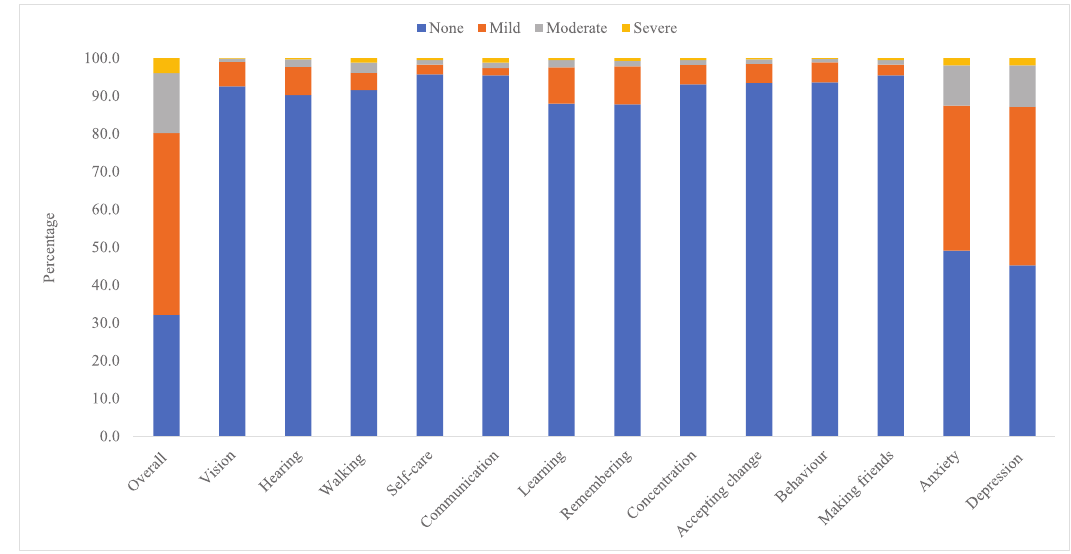
Fig 3. Percentage distribution of disability category by CFM domains (n = 1,439).